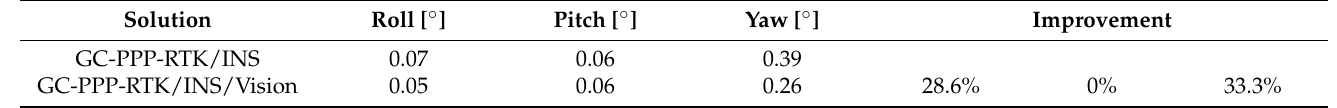
Table 9. RMS of the attitude error of T02 for GC-PPP-RTK/INS and